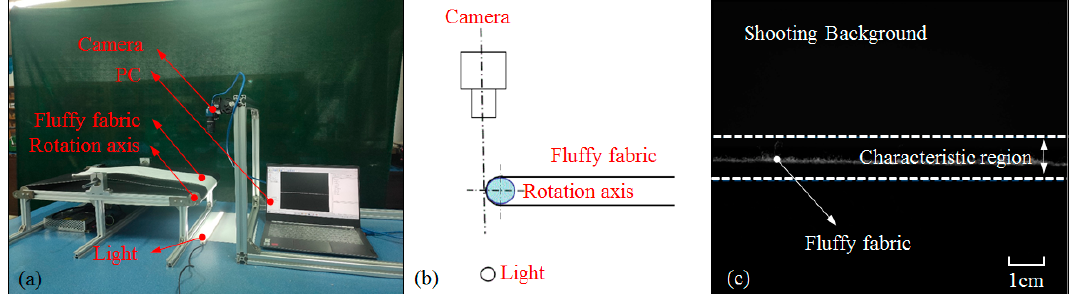
Figure 1. Experimental platform of the fleece fabric visual system: ( a ) an overview image; ( b ) a schematic diagram; ( c ) an acquired image.